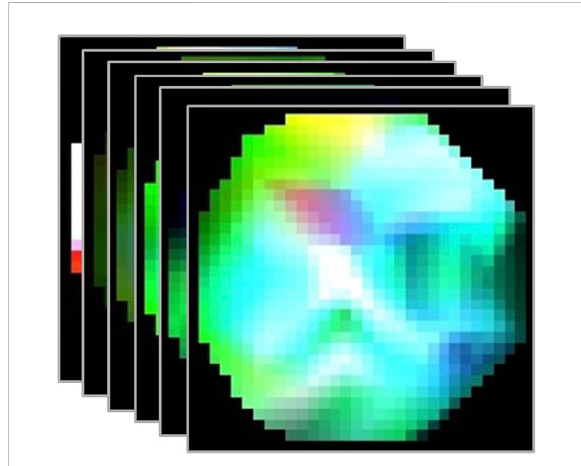
FIGURE 4 Sample of 6 contiguous frames of EEG video representation from the EEG Baseline dataset for the eyes open